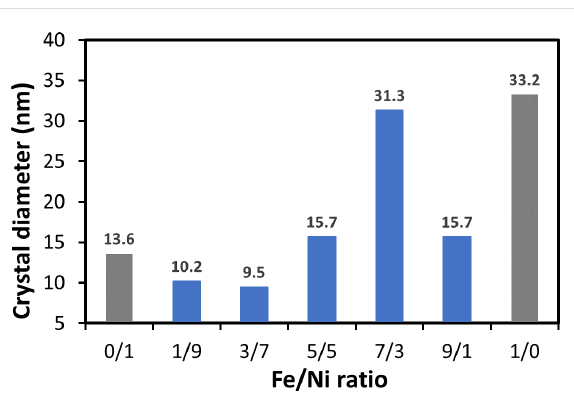
troscopy (DRS) and photographs of various LaFe x Ni 1 − x O 3